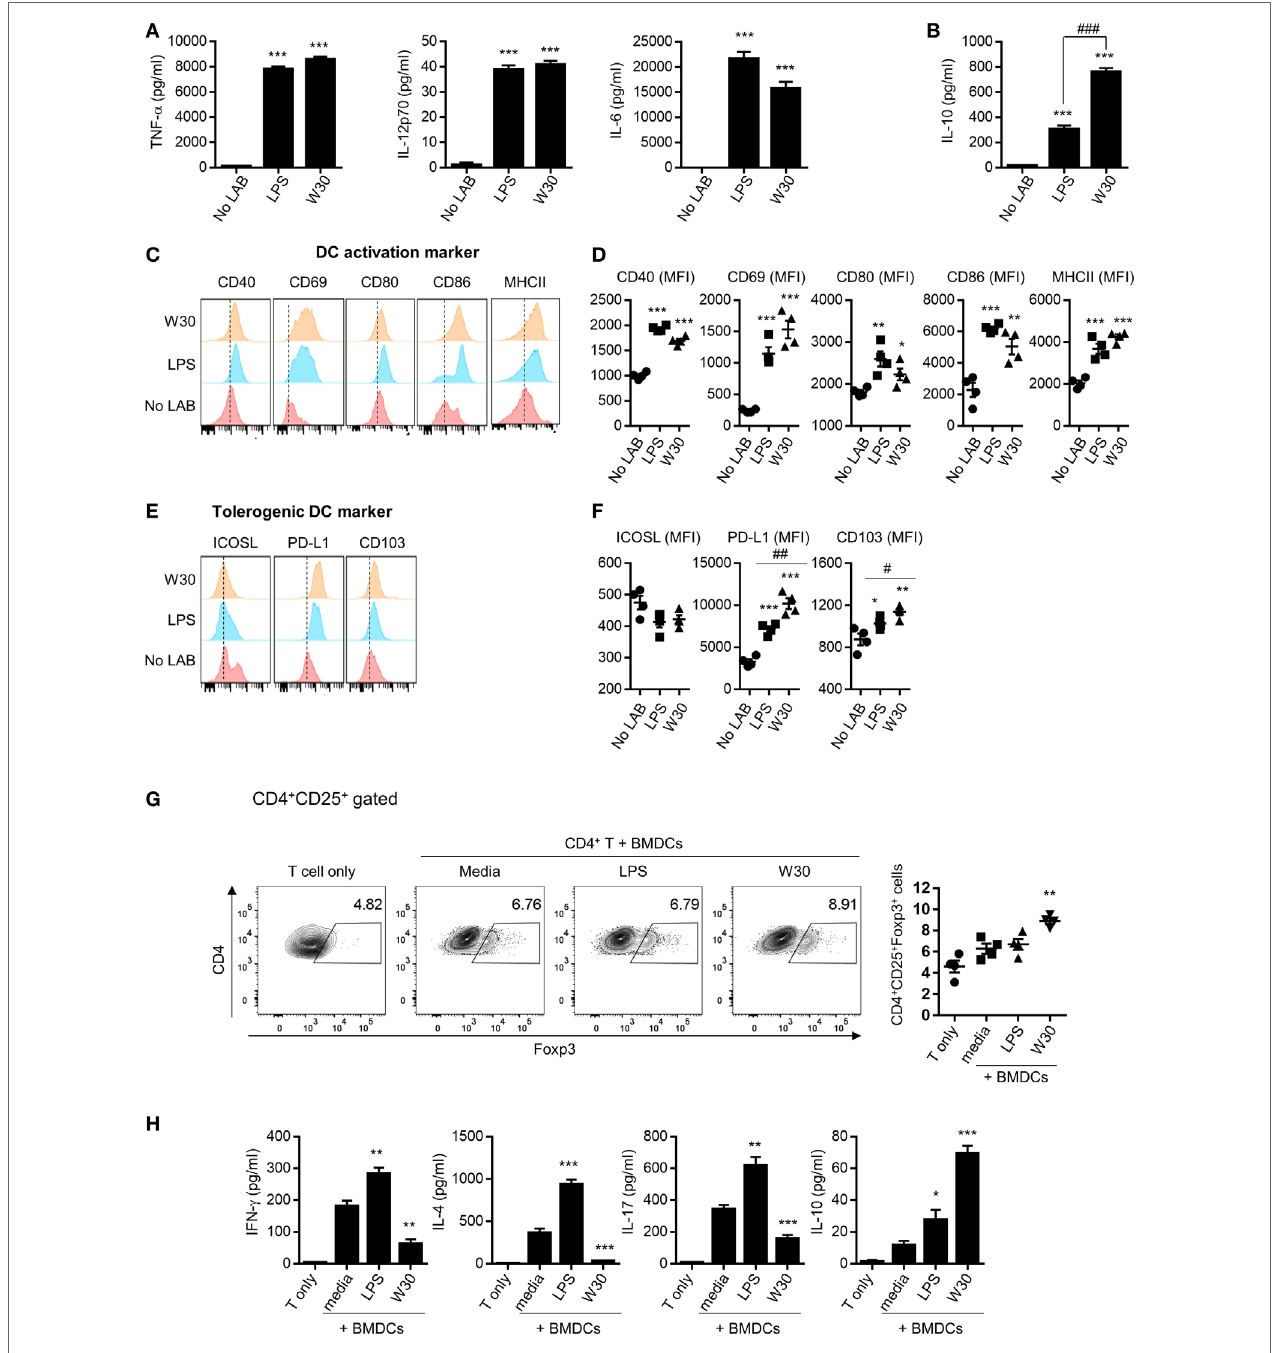
FigUre 1 | WIKIM30 modulates dendritic cell (DC) and T cell function in vitro . Bone marrow-derived DCs (BMDCs) were generated from naïve bone marrow cells of BALB/c mice in the presence of granulocyte-macrophage colony-stimulating factor. BMDCs were cultured with or without LPS and WIKIM30 for 24 h. (a,B) Expression levels of pro-inflammatory [TNF- α , interleukin (IL)-12p70, and IL-6] or anti-inflammatory (IL-10) cytokines in the culture supernatant measured with the cytometry bead array. (c,D) Surface expression of markers related to DC maturation (CD40, CD69, CD80, CD86, and MHCII) or tolerogenic DCs [inducible T-cell costimulator ligand (ICOS-L), programmed death ligand (PD-L)1, and CD103] was detected by flow cytometry. * p < 0.05 vs. no lactic acid bacteria (LAB) group; # p < 0.05 vs. LPS group. (e,F) BMDCs were stimulated with LPS or WIKIM30 for 24 h and cocultured with CD4 + T cells isolated from BALB/c mice in the presence of anti-CD3 monoclonal antibody for 4 days, and the proportion of CD4 + CD25 + Foxp3 + regulatory T cells analyzed by flow cytometry (g) while expression levels of cytokines (IFN- γ , IL-4, IL-17, and IL-10) in the culture supernatant were measured with the cytometry bead array (h) . Data are representative of three independent experiments. Student’s t -test (unpaired); * p < 0.05, ** p < 0.01, *** p < 0.001 vs. medium group; # p < 0.05, ## p < 0.01, ### p < 0.001 vs. LPS